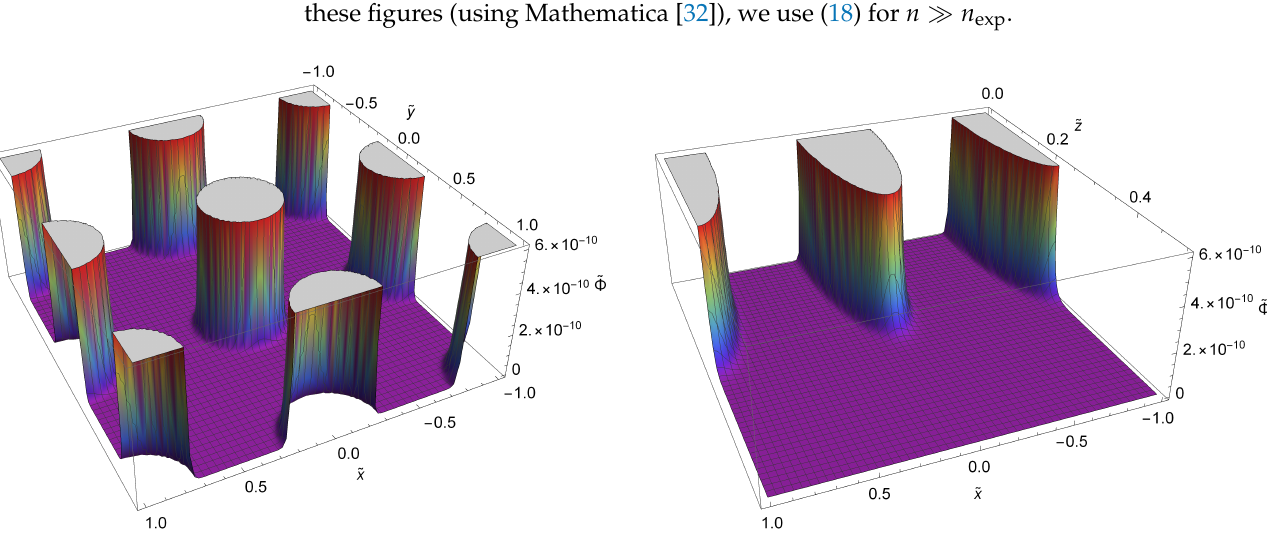
(cid:2) − (cid:3) − 1 G N m / ( c 2 al ) Figure 1. ˜ Φ = (cid:98) Φ for ˜ λ eff = 0.01 for the sections z = 0 (left panel) and y = 0 (right